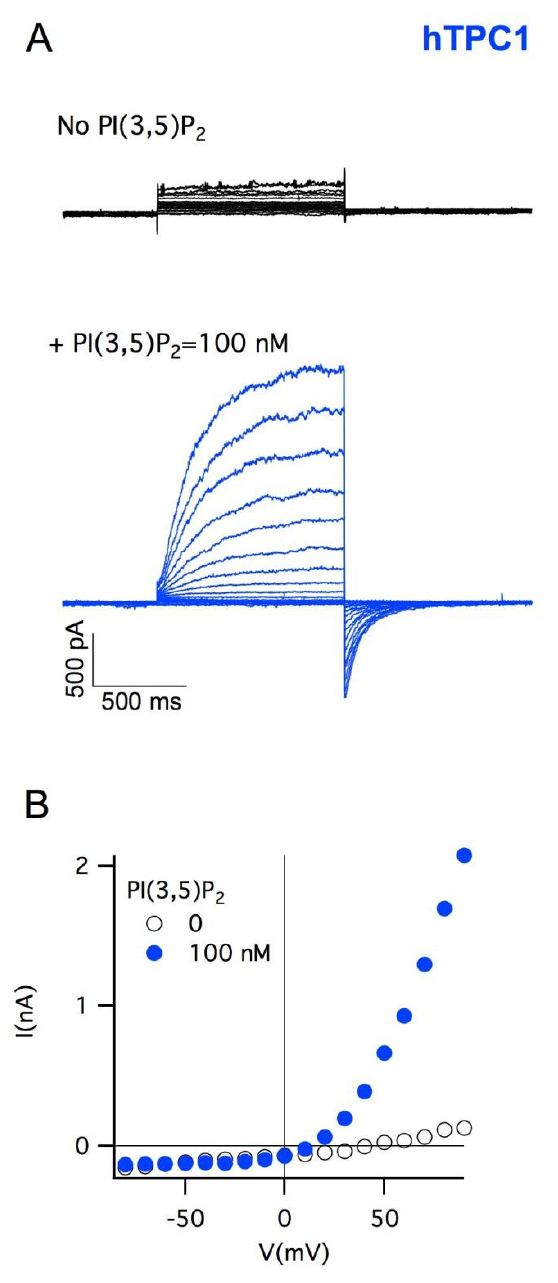
Figure 4. Human TPC1 is functional when transiently expressed in vacuoles from mesophyll cells of Arabidopsis plants lacking endogenous tpc . ( A ). Currents recorded at different voltages, from − 80 mV to 90 mV, step +10 mV, in a symmetrical concentration of sodium (100 mM), respectively, in the absence and in the presence of 100 nMPI(3,5)P 2 show that hTPC1 is activated by this phosphoinositide. Tail pulse at − 50 mV. ( B ) From the I–V characteristics of the currents displayed in A, it is evident that hTPC1 is a voltage-dependent, outward-rectifying channel. The standard pipette (luminal side) solution contained (in mM): 100 NaCl, 2 MgCl 2 , 1 CaCl 2 , 10 MES, pH 5.5 (with NaOH). The standard bath (cytoplasmic side) solution contained (in mM): 100 NaCl, 10 Hepes, pH 7.5 (with NaOH). The osmolarity of the luminal and cytoplasmic solutions was adjusted to 550 mOsm and 600 mOsm, respectively, by the addition of